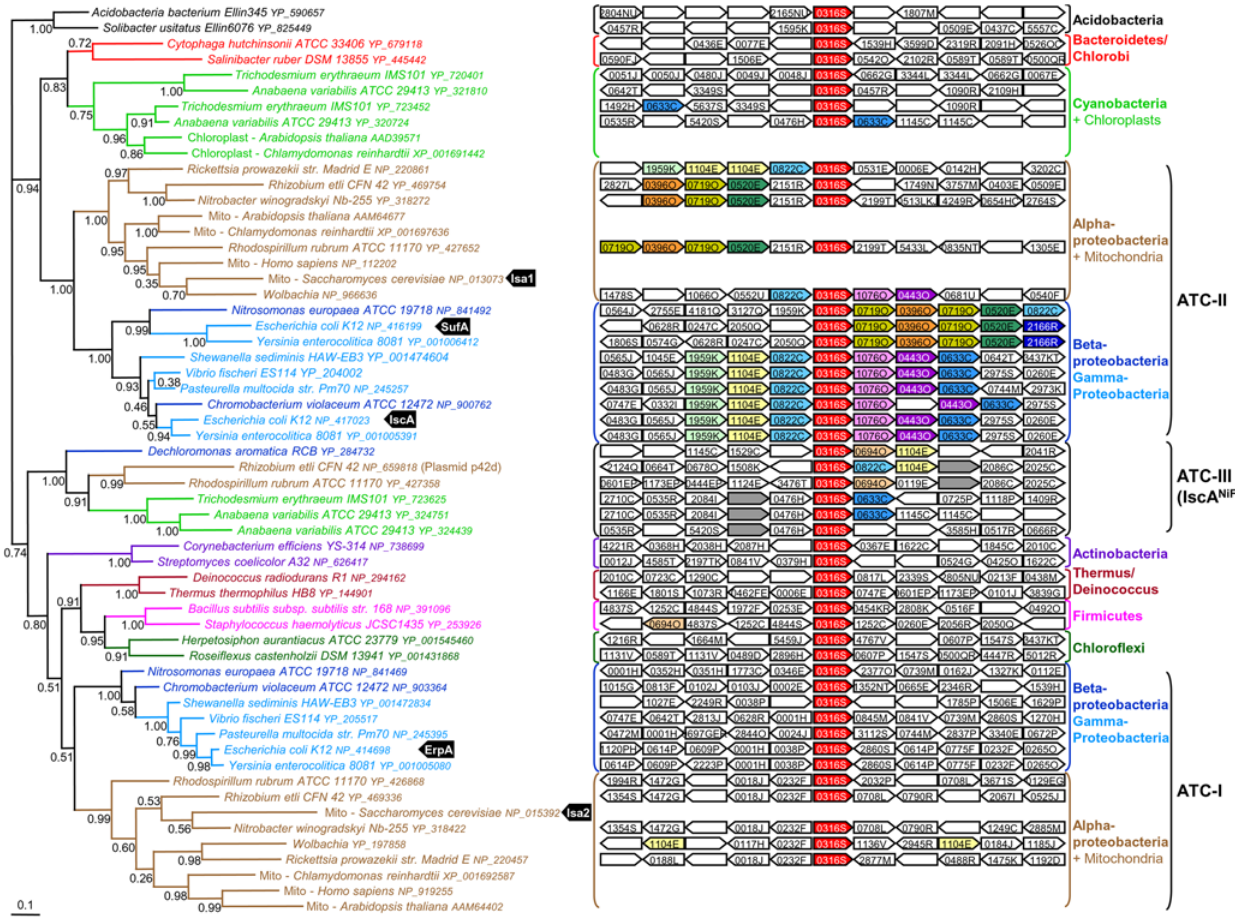
Figure 2. Phylogeny of the ATC proteins. Left part: Bayesian tree of a sample of 58 ATC sequences representative of the ATC family diversity. Numbers at nodes represent posterior probabilities. The scale bar represents the average number of substitutions per site. Right part: for each bacterial homolog, the genomic organization of regions surrounding ATC coding genes (ATC, COG0316S, red boxes) is shown. Numbers in boxes correspond to COG (Cluster of Othologous Groups) numbers. Colored boxes represent genes coding for components of the ISC system [HscB (COG1076O, pink boxes); HscA (COG0443O, purple boxes); Fdx (COG0633C, blue boxes); IscU (COG0822C, light blue boxes); IscS (COG1104E, yellow boxes) and IscR (COG1959K, light green boxes)], the SUF system [SufB/D (COG0719O, dark yellow boxes); SufS (COG0520E, dark green); SufC (COG0396O, orange boxes) and SufE (COG2166R, dark blue boxes)] or the NIF sytem [NifW (dark grey), NifU (COG0694O, light orange), NifS (COG1104E, yellow boxes)].